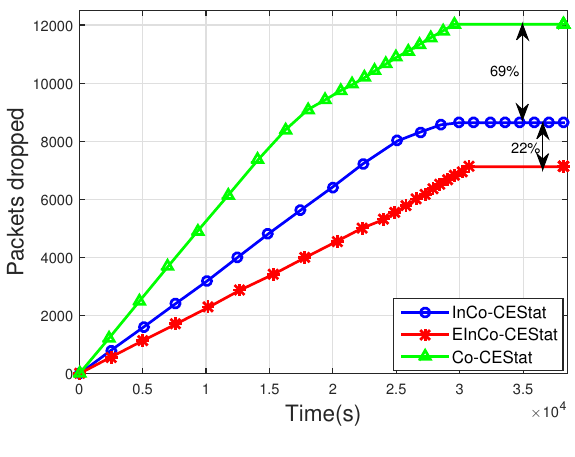
Figure 8. Number of packets